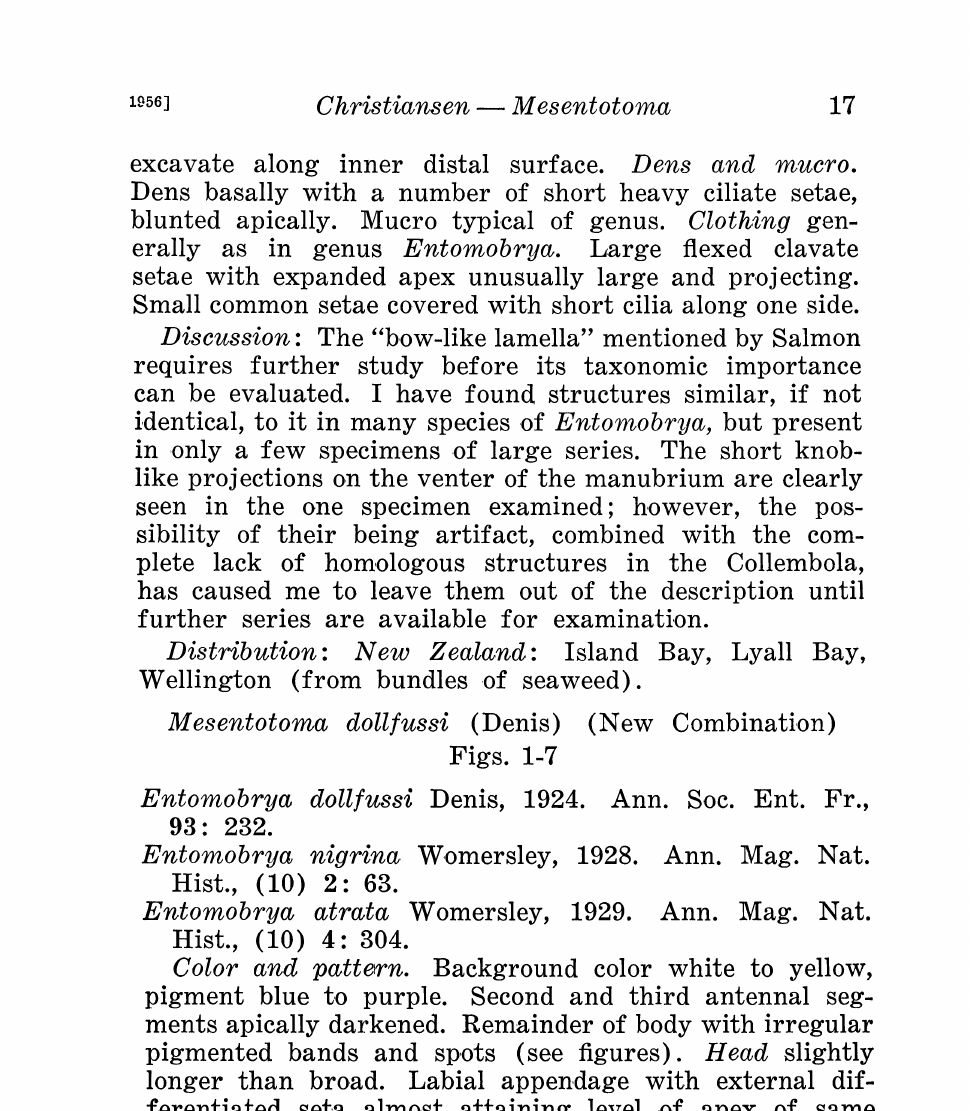
Color and pattern. Background color white to yellow, pigment blue t.o purple. Second and third antennal seg- ments apically darkened. Remainder of body with irregular pigmented bands and spots (see figures). Head ,slightly longer than bro.ad. Labial appen.dage with external dif- ferentiated seta almost attaining level .of apex of same papilla. Labral papillae truncate. Antennae with apical bulb of fourth segment bilobed, in a deep apical pit. Sense organ of third segment with two angled blunt thick setae, one conical guard seta. Second segment with two similar blunt setae more widely separated than those on third segment. Second segment with definite basal